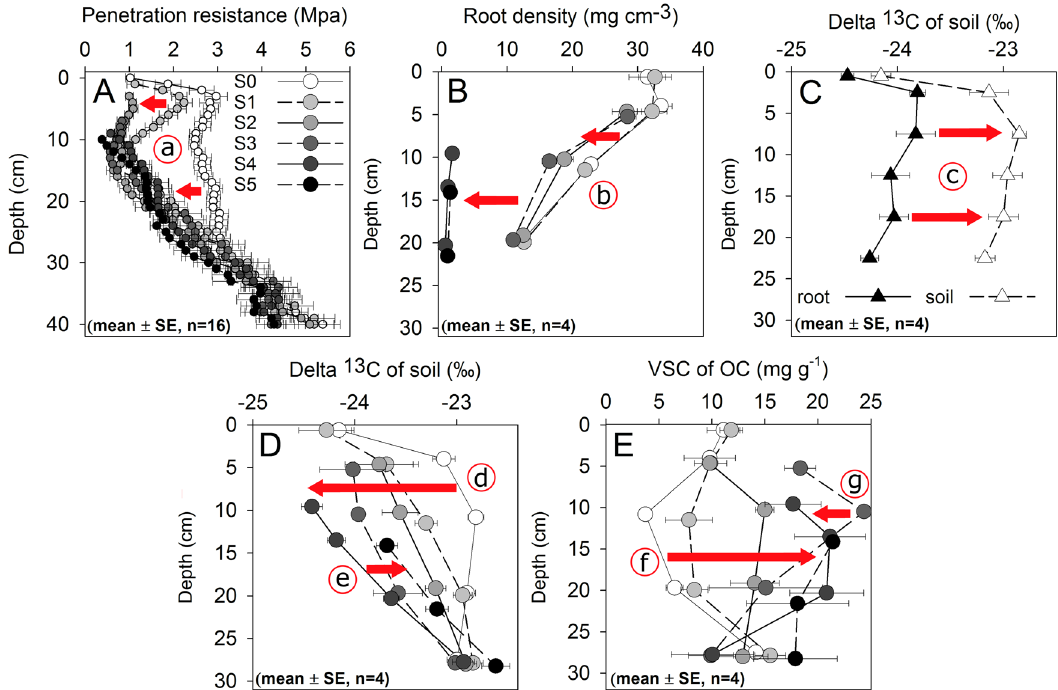
Fig. 2 Changes in soil characteristics with depth according to degradation stage. A Penetration resistance, B root density, C δ 13 C of soil and roots, D δ 13 C of soil organic carbon (SOC), E content of lignin monomers vanillyl, syringyl, and cinnamyl (VSC). All parameters (means ± SE, n = 4) are presented for each soil horizon at depth midpoint, except for penetration resistance ( A ) and δ 13 C values of soil and roots ( C ), which are shown in 1 and 5 cm increments, respectively. Exact data are given in Supplementary Table 2. Progressive changes along the degradation sequence can be explained by the